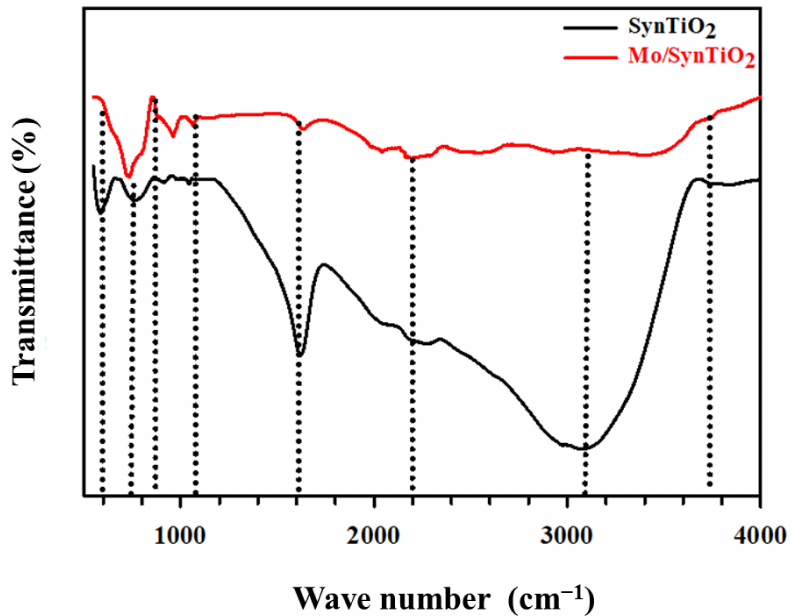
Figure 2. FTIR measurement for unmodified SynTiO 2 (black line) and modified Mo/SynTiO 2 (red